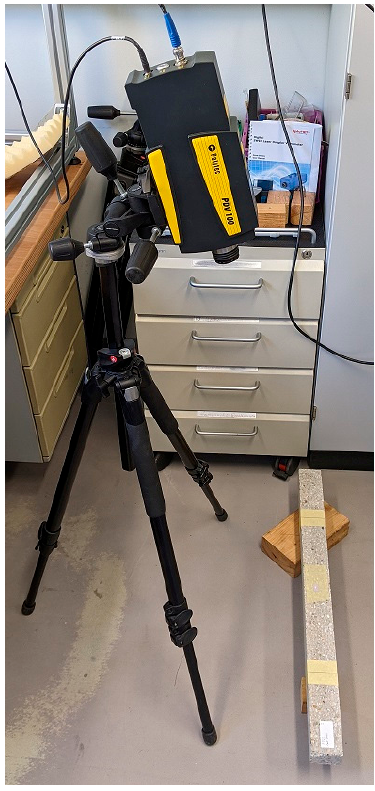
Figure 9. An overall view of the test setup.